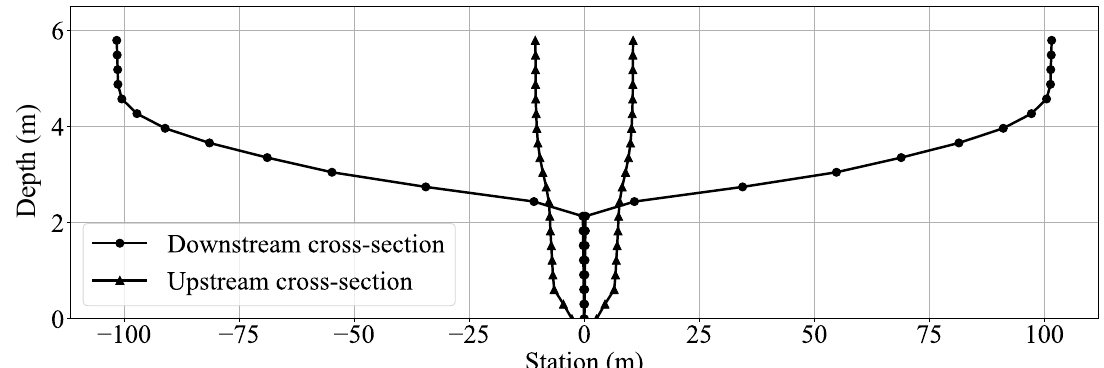
Figure 8. Cross-sectional geometries of the problematic adjacent channel segments highlighted in Figure 7.